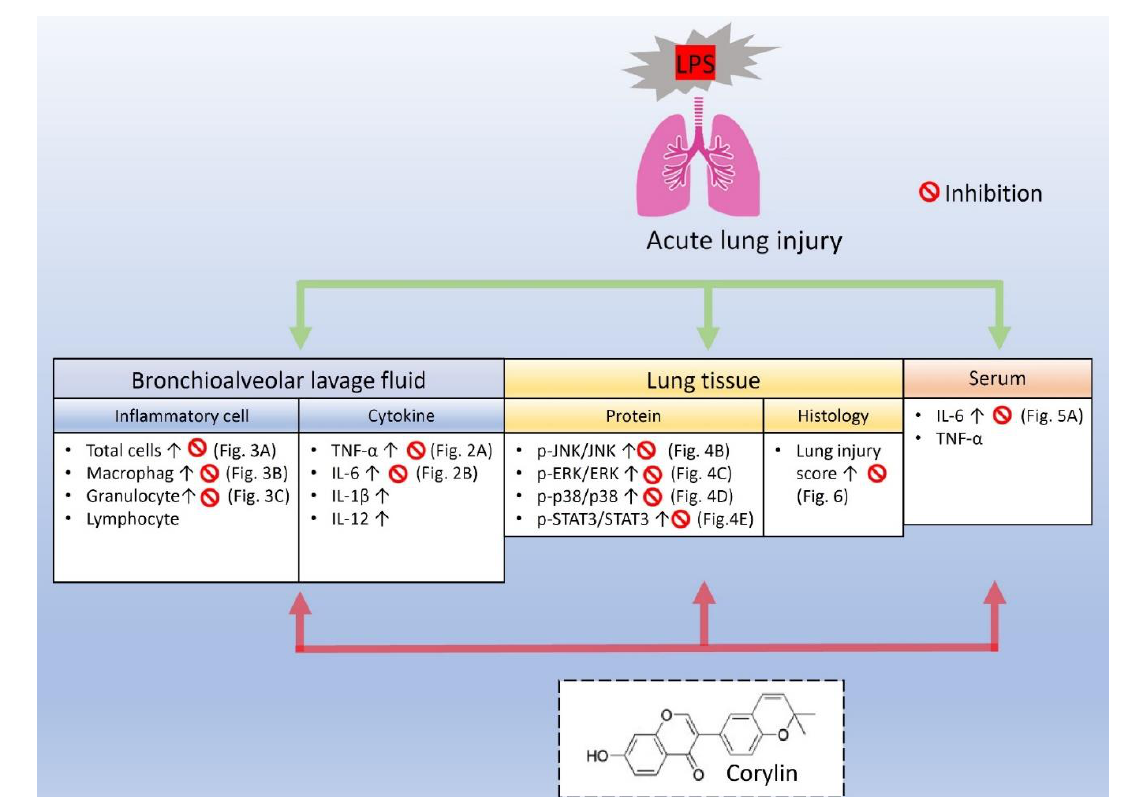
Figure 7. Anti-inflammatory effect of corylin on LPS-induced ALI. The experimental results demonstrated that corylin attenuated the overproduction of IL-6 in LPS-activated human bronchial epithelial cells. In intratracheal LPS-induced ALI mice, corylin attenuated tissue damages, suppressed inflammatory cell infiltration, and decreased secretion of IL-6 and TNF- α in the BALF and serum; moreover, it further inhibited the expression of phosphorylation of mitogen-activated protein kinases (MAPKs), including the expression of p-JNK/JNK, p-ERK/ERK, p-p38/p38, and repressed the activation of signal transducer and activator of transcription 3 (STAT3) in lung. Taken together, our results are the first to demonstrate the anti-inflammatory effects of corylin on LPS-induced ALI and suggest corylin has significant potential as a novel therapeutic agent for ALI.